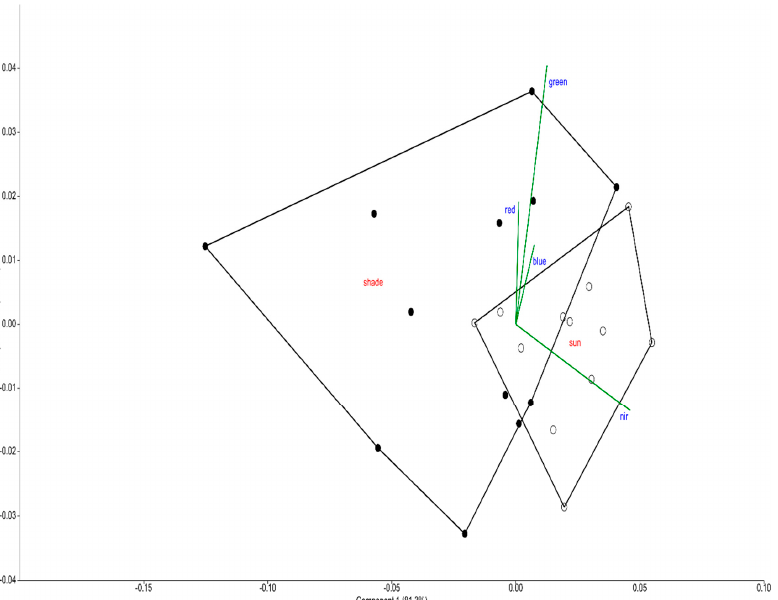
Figure 6. PCA of the spectral response features of sun (open circles) and shade (black circles) leaves of Phragmites australis in Lake Balaton. Axis 1 explains 81.3% of the variation, axis 2—14.5%.